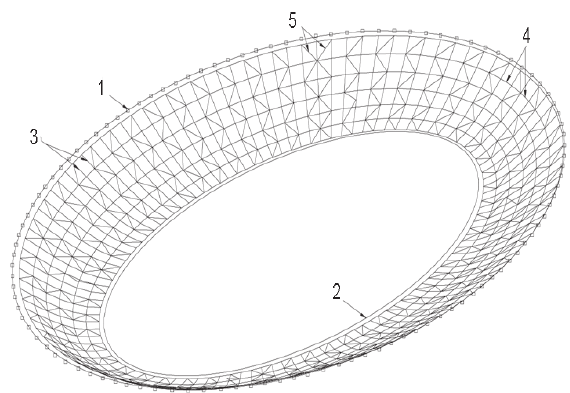
Fig. 1. Long-span latticed roof with a large elliptical opening: 1, 2 – external and internal supporting contours; 3, 4, 5 – radial, annular and diagonal members